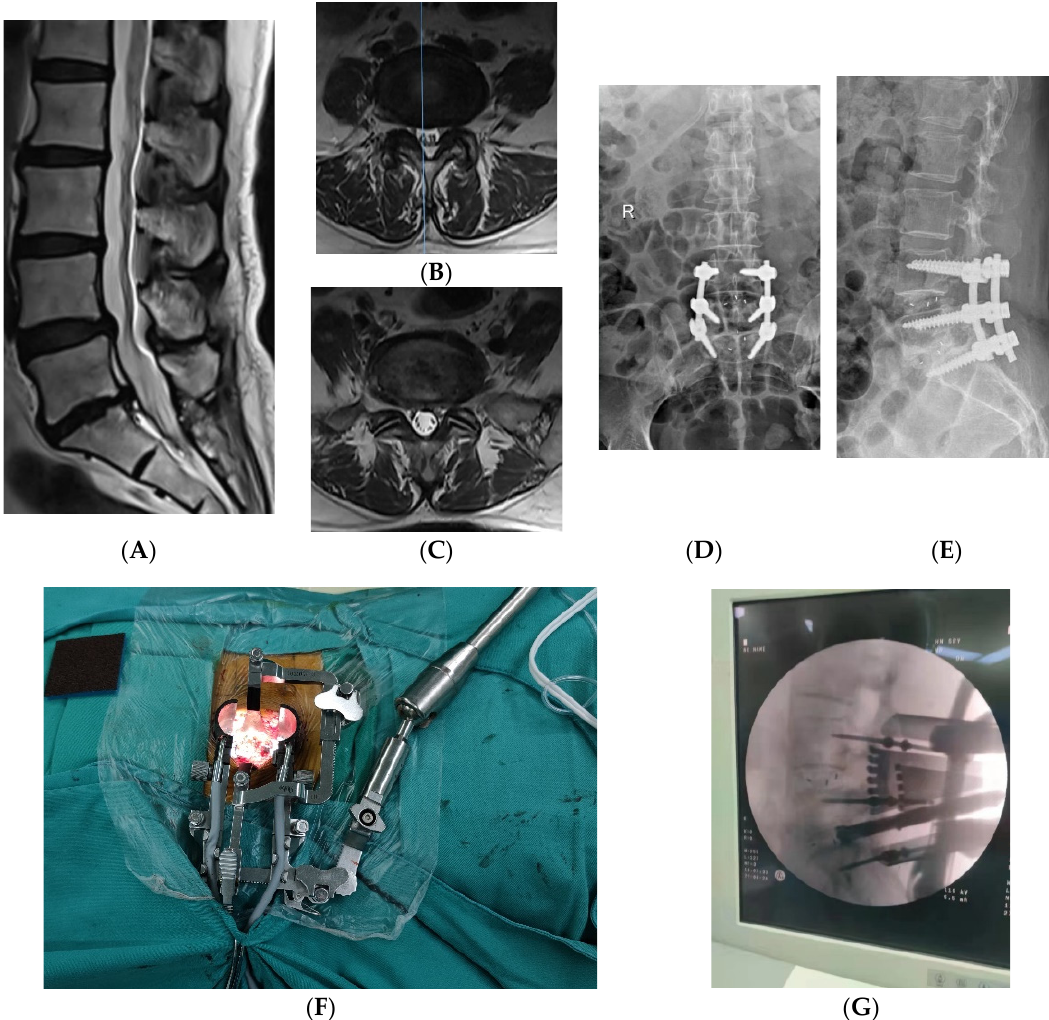
Figure 3. A typical case in the MIS-TLIF group. A 64-year-old woman was admitted to the hospital because of “waist pain for more than 10 years, aggravated with lower limb discomfort for 3 months”, and underwent two-stage Mis-TLIF surgery. ( A – C ) show MRI imaging examination of disc herniation in L4/5 and L5/S1, disc degeneration in L5/S1, and narrowing of intervertebral space. ( D , E ) show postoperative X-ray. ( F , G ) The Quadrant minimally invasive operating system and an intraoperative fluoroscopic image, respectively.